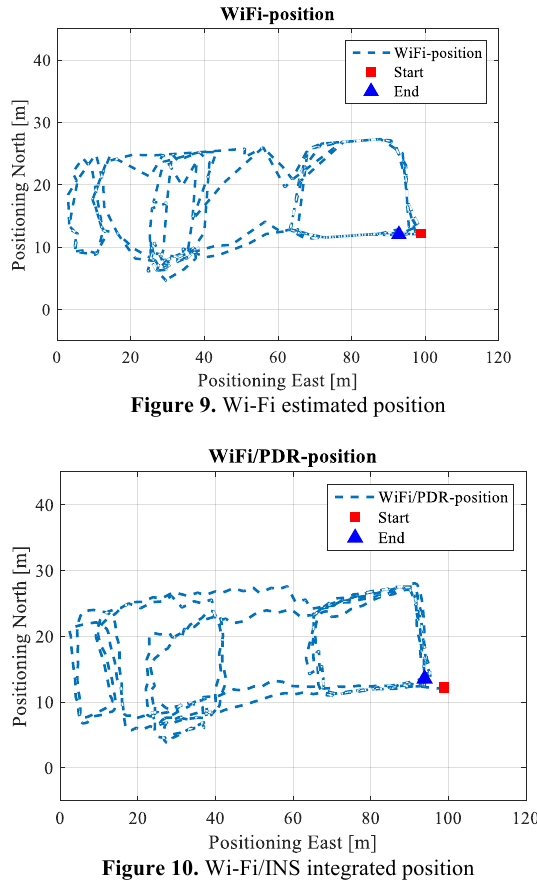
Figure 10. Wi-Fi/INS integrated position Figure 11 is a Map/Wi-Fi/INS integrated position using the APF-based Map aiding method. By comparing Figure 11 with the reference trajectory in Figure 7, it is obvious that the estimated trajectory almost matches the reference